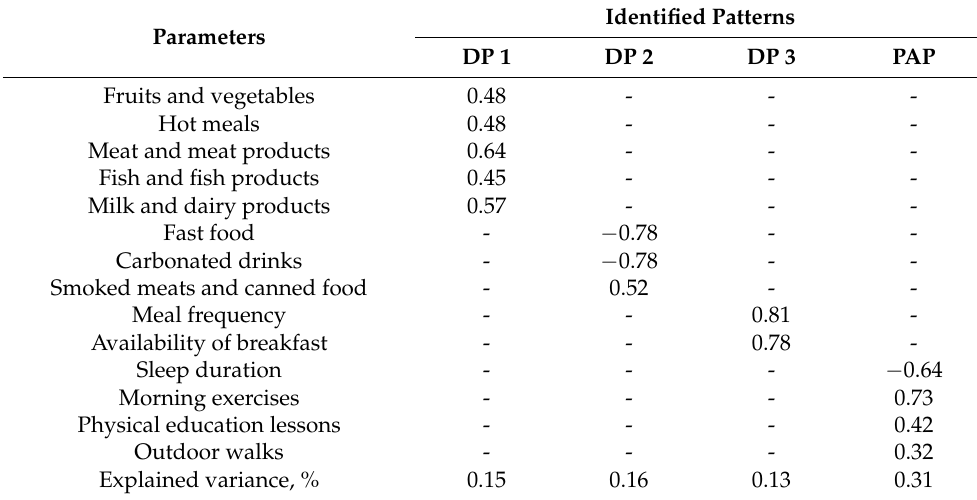
Table 2. Factor loadings of main identified dietary and PA